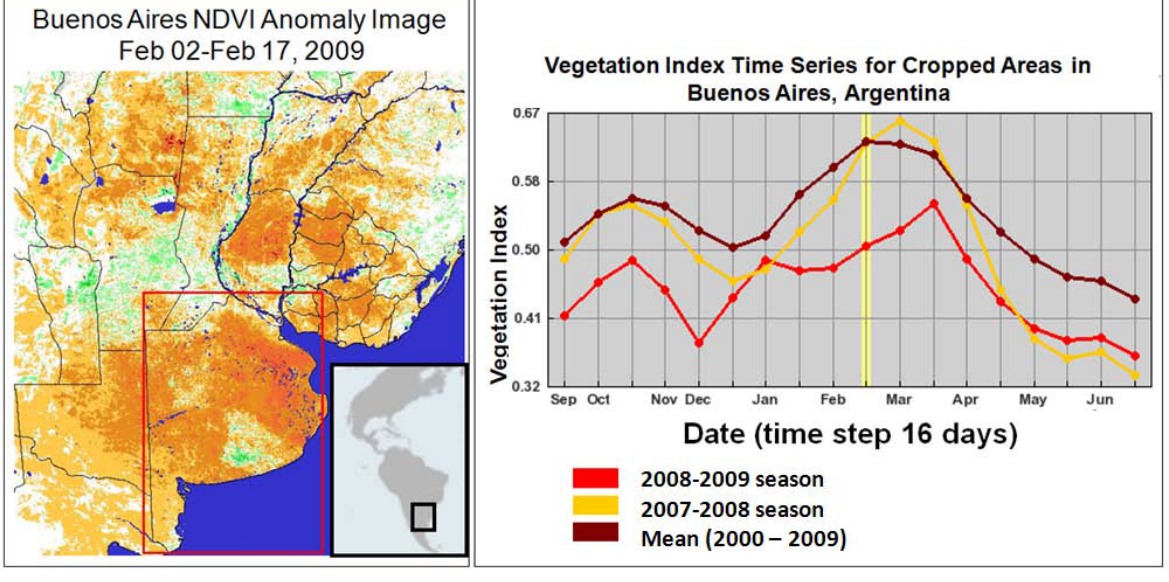
Figure 1. Example of utility of the GLAM MODIS NDVI DBMS to track 2009 drought impact on crops in Buenos Aires district in